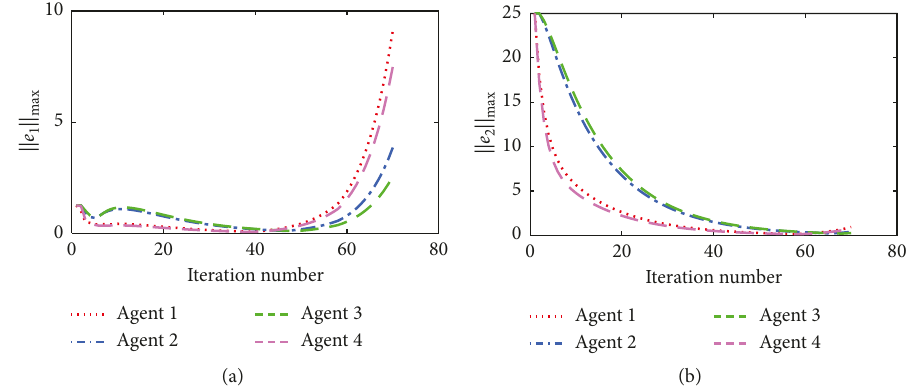
Figure 7: Results with open-loop D -type FOILC. (a) Tracking error e